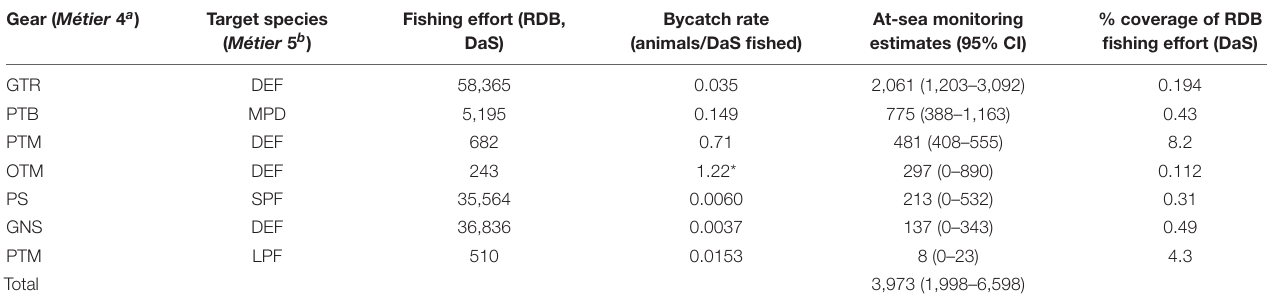
TABLE 7 | Summary of the bycatch rate and mortality of common dolphins for métiers of concern from at-sea monitoring (ICES subareas 27.8.a and 27.8.b, data pooled 2016–2018), raised using the annual mean of available fishing effort from the Regional DataBase (RDB, i.e., data collected in the context of the Data Collection Framework; in ICES,